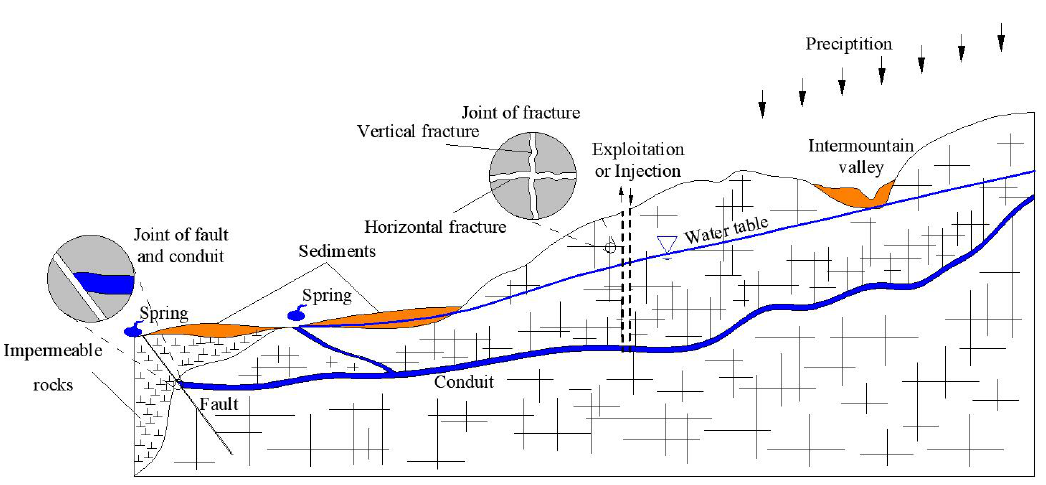
Figure 2. The conceptual model of Jinan karst aquifer system .